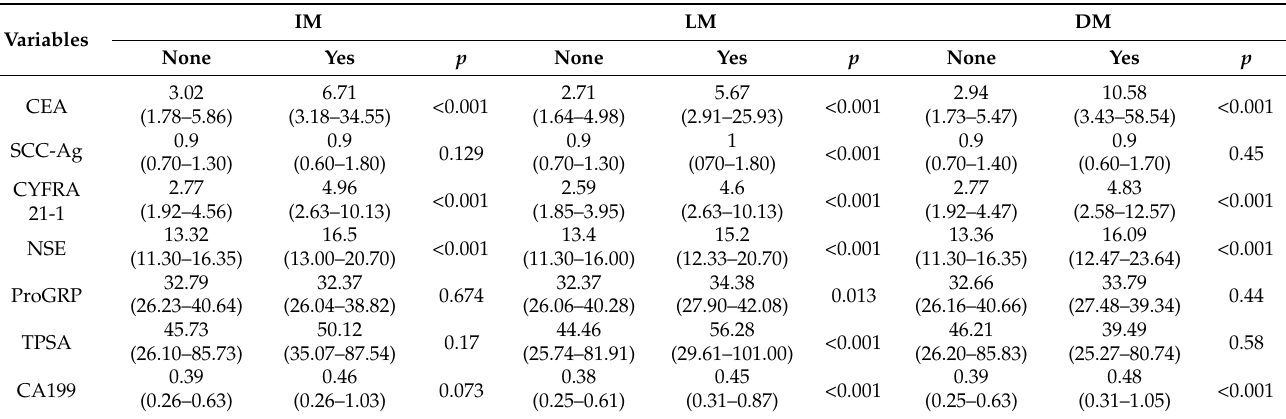
Table 3. The difference in tumor metastasis for the tumor markers in the patients with NSCLC (CEA, SCC-Ag, CYFRA 21-1, NSE, ProGRP, TPSA and CA199).